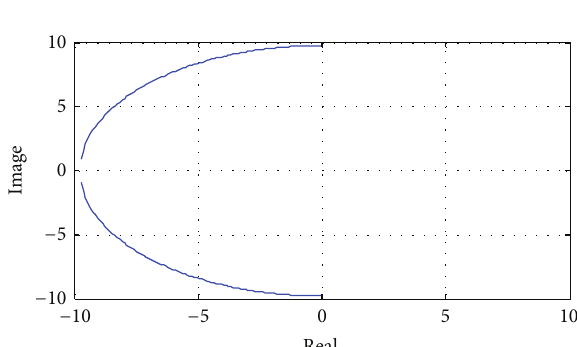
Figure 5: Stability analysis of velocity feedback control for smart